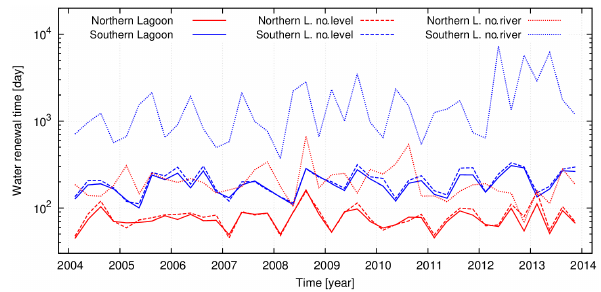
Figure 10. Water renewal times for the northern and southern basin. The WRT is computed every 3 months to obtain a seasonal estimate. WRT is computed for the reference run (continuous line), with no water level variation in the Baltic Sea (dashed line), and with no river discharge (dotted line). The results for the no baroclinic run are not shown because they are basically identical to the reference simulation. The northern lagoon is in red, the southern lagoon in blue.